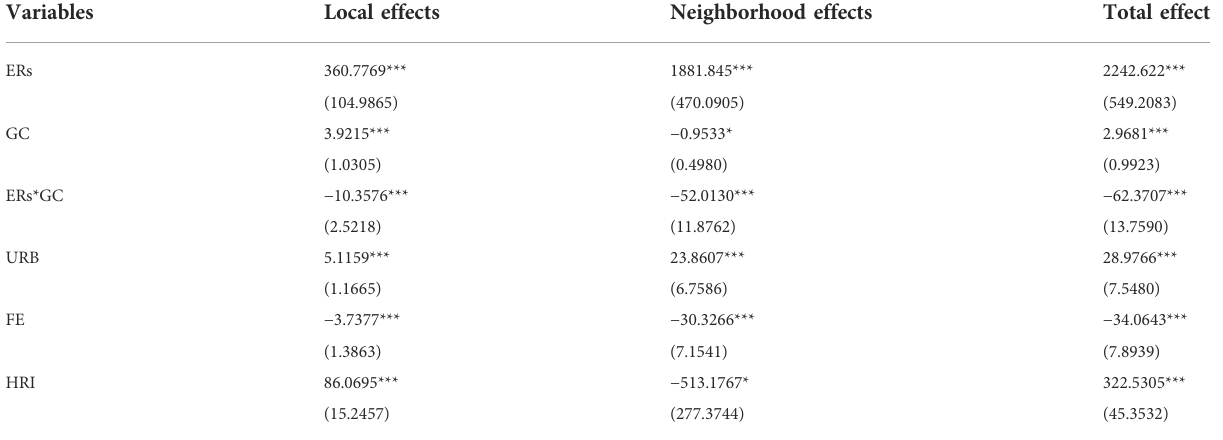
TABLE 3 Results of spatial effect